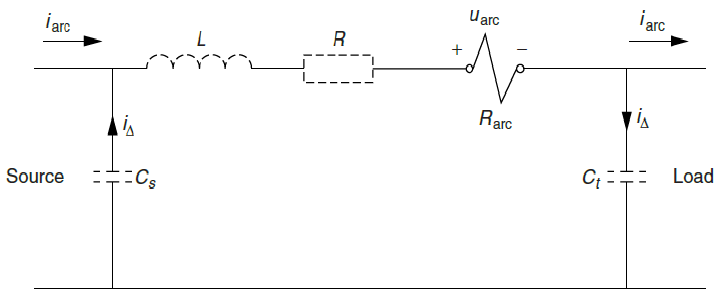
Figure 2. Interruption of the small inductive